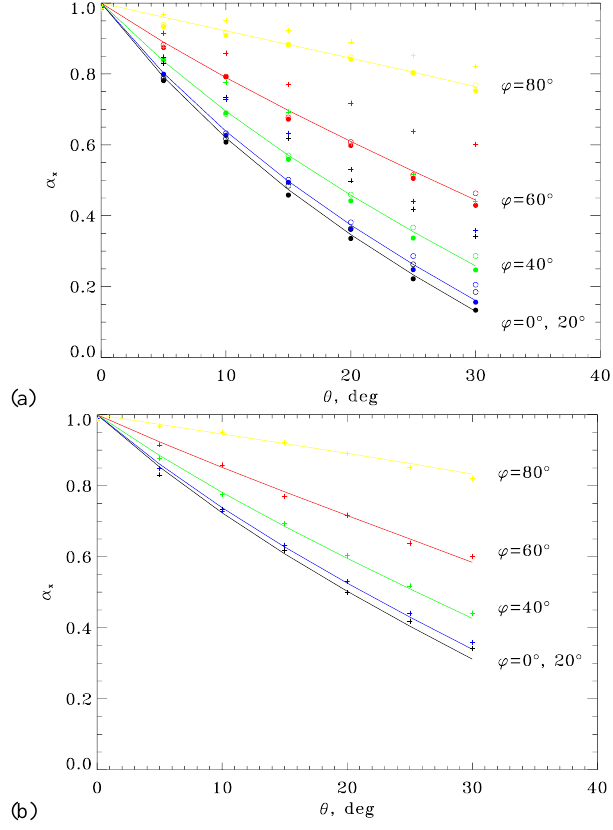
Fig. 5. (a) Ratio of the currents collected by opposite pairs, a – c and b – d , of the ADV collector as a function of the co-latitudinal angle of the ion flow, given for different values of the azimuthal angle. The temperature of the ion population is chosen to be 0.2eV and the parallel velocity is 7.25kms − 1 . Filled and open circles and crosses represent the results of the numerical calculation for O + , He + , H + , respectively. Solid lines show the behaviour which is predicted by the “cold plasma” approximation (12a). Black, blue, green, red and yellow colours are used to plot the analyser’s response for the ions flows with the different azimuthal angles, i.e. 0 ◦ , 20 ◦ , 40 ◦ , 60 ◦ and 80 ◦ . (b) Current ratio that is produced on the collector by the hydrogen flow (crosses) in the same plasma conditions as in (a). Solid lines show the behaviour that is fitted by Eq. (12a), in which the diaphragm’s half-size is replaced by its effective value, r ∗ 22mm.